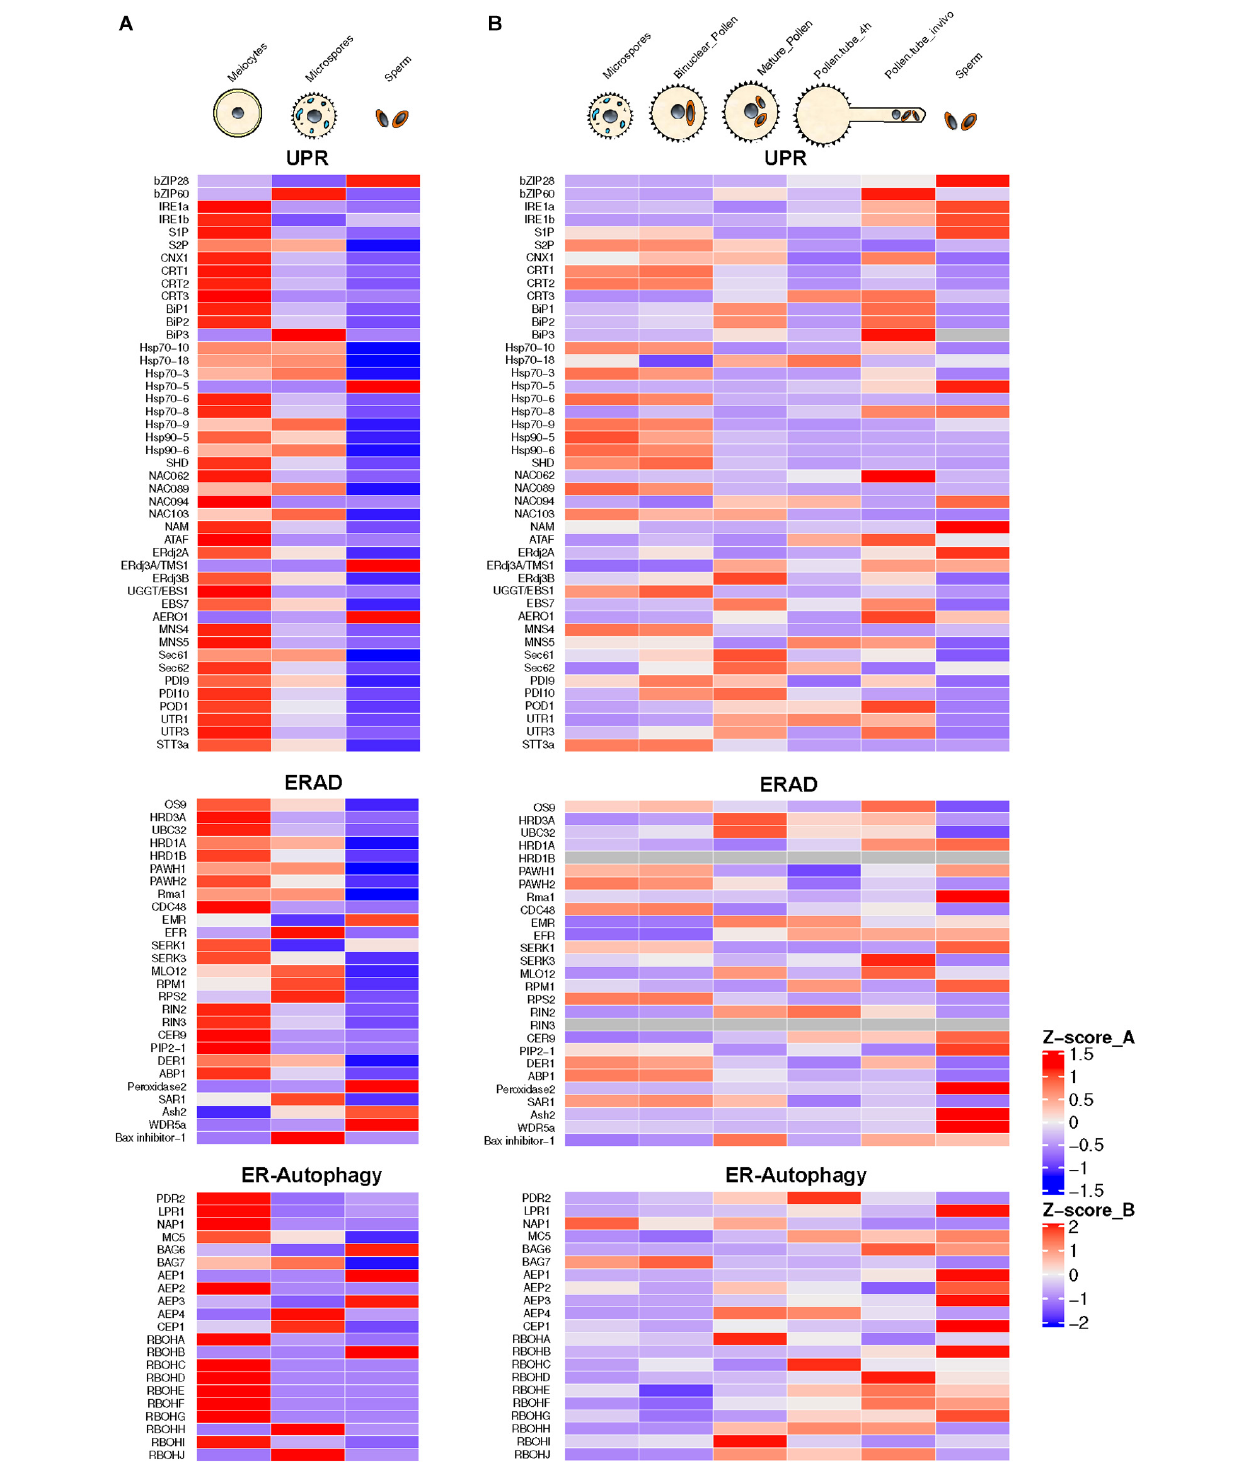
FIGURE 2 | Annotation and expression of ER stress component genes in Arabidopsis developing pollen, pollen tubes, and sperm cells. The data were compiled using the gene expression obtained from RNA-seq based analysis (A) or microarrays (B) . RNA-seq data sets from previously published literature were downloaded from the NCBI Sequence Read Archive database. For Microarray data, the expression values were downloaded from the Arabidopsis Heat Tree Viewer (http://arabidopsis-heat-tree.org/). The gray color in the heatmap denotes missing values. Full details available in Supplementary File 1 .